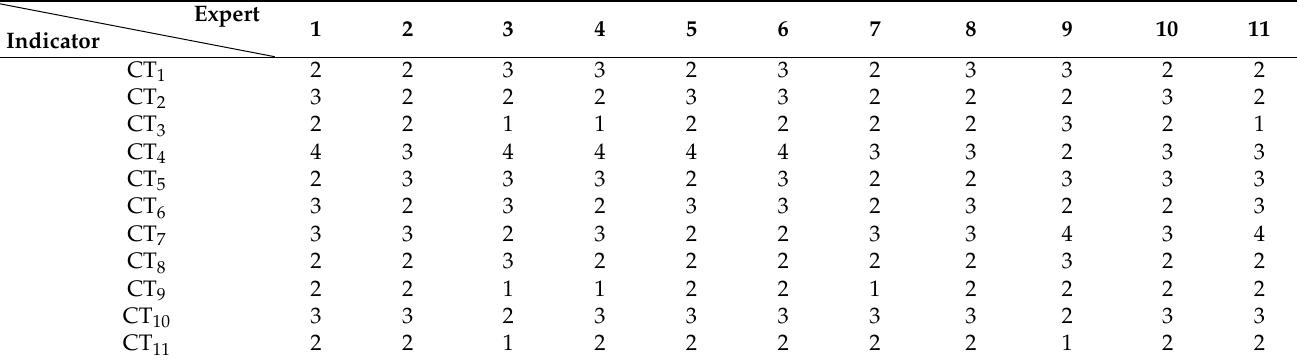
Table A1. Raw data of construction technical risk (CT).